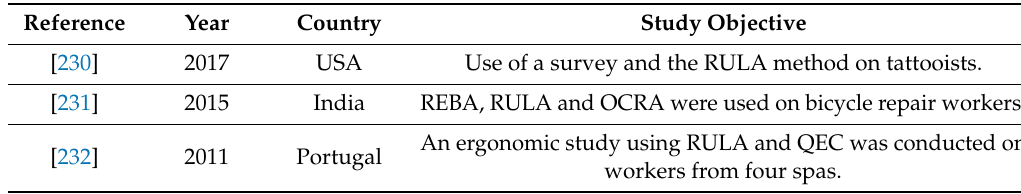
Table 19. Other service